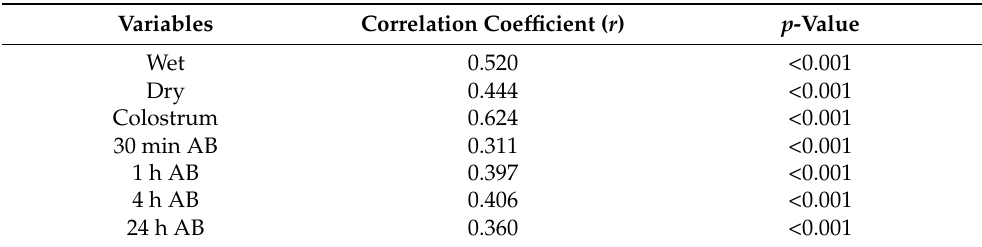
Table 15. Significant correlations between puppies’ weight and their superficial temperature at TLBB thermal window.